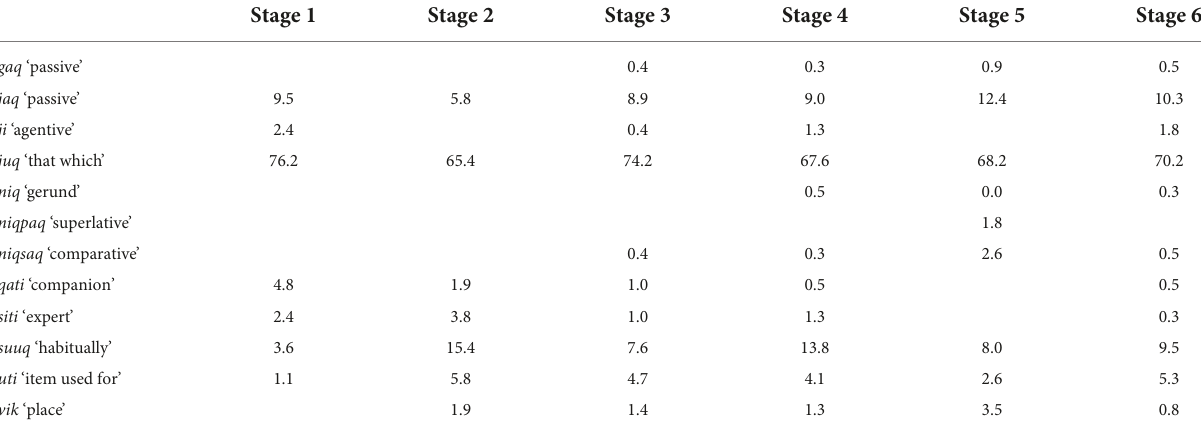
TABLE 8 Frequencies of nominalizers as a proportion of the total number of nominalizers used in the data, by stage. Stage